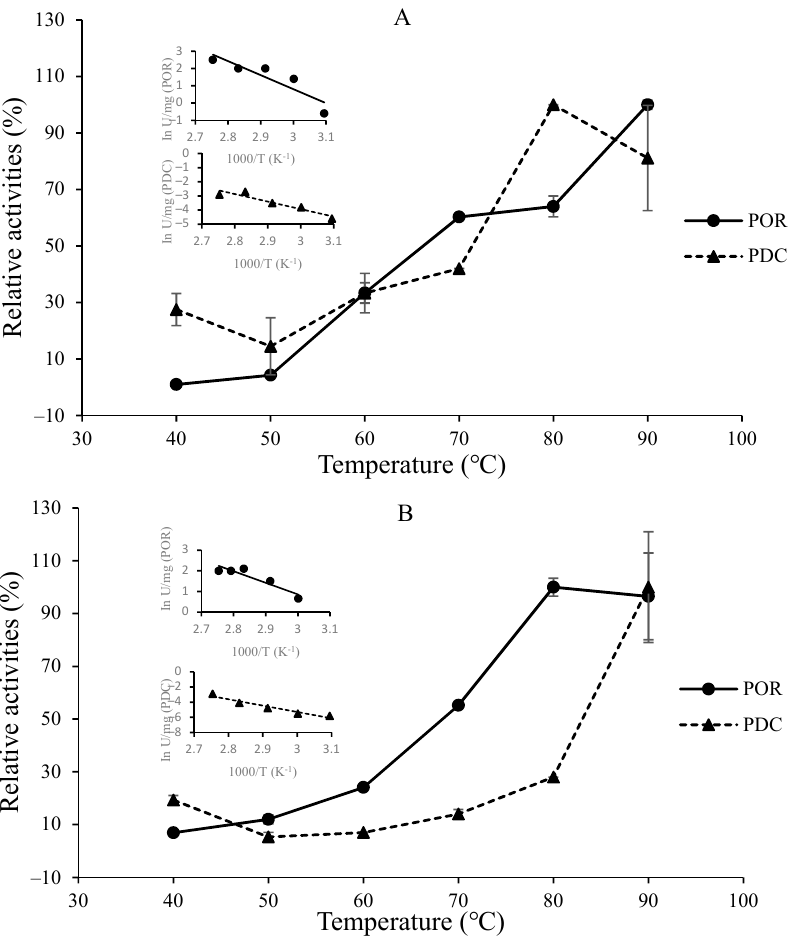
Figure 3. Temperature dependence of the POR and PDC activities of the bifunctional POR/PDCs from S. solfataricus ( A ) and S. acidocaldarius ( B ). POR and PDC enzyme activities were determined over a temperature range from 40 to 90 °C. The assay mixture of POR contains 100 mM sodium phosphate pH 8.0, 5 mM pyruvate, 100 µM CoA, 1 mM benzyl viologen and approximately 50 µM sodium dithionite. The PDC assay mixture was 100 mM sodium phosphate at pH 8.0, 10 mM pyruvate, and 100 µM CoA. The relative activities of 100% are equal to the highest specific activities (12.1 U/mg for SsPOR, 0.069 U/mg for SsPDC, 8 U/mg for SaPOR, and 0.057 U/mg for SaPDC activities). The insets show the Arrhenius